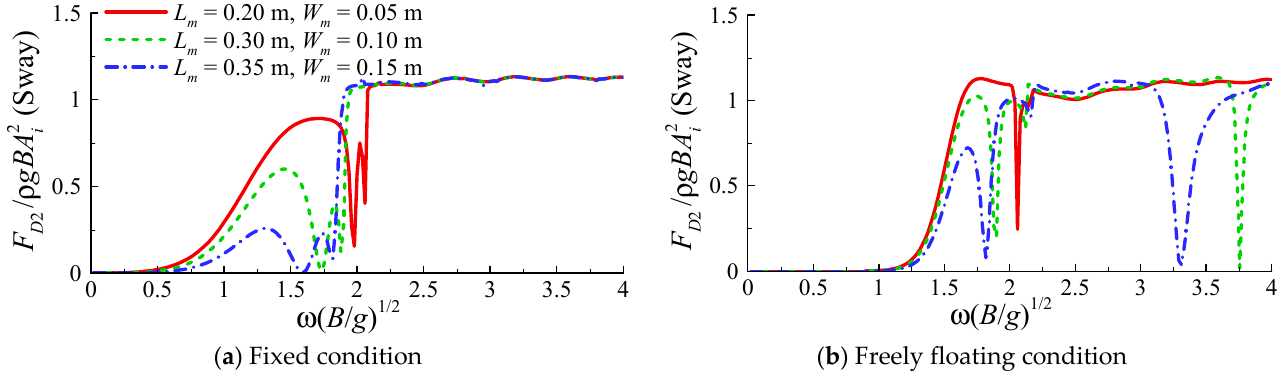
Figure 11. Influence of the size of moonpools on mean sway drift force of a barge in beam waves.